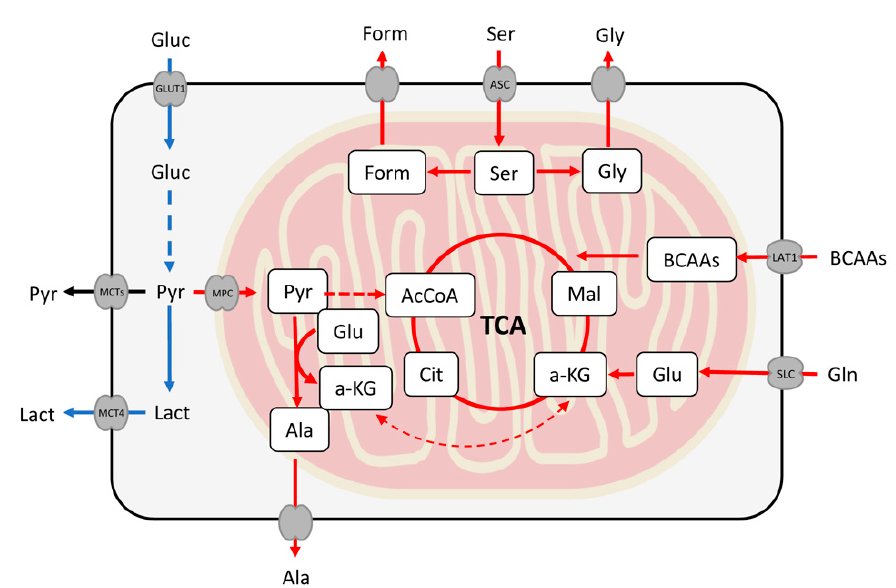
Figure 6. Differently regulated biochemical pathways in the UBC cell lines studied. The blue arrows represent the active metabolism in cells associated with high risk of progression (5637), while the red arrows represent those at low risk (RT4). The RT112 line presents a lower catabolism of serine, which is manifested in a lower excretion of formate and glycine. The abbreviations used are the same as in Figure 5, plus AcCoA: acetyl-CoA, a-KG: alpha-ketoglutarate, Cit: citrate, Glu: glutamate, Gly: glycine, Mal: malate.